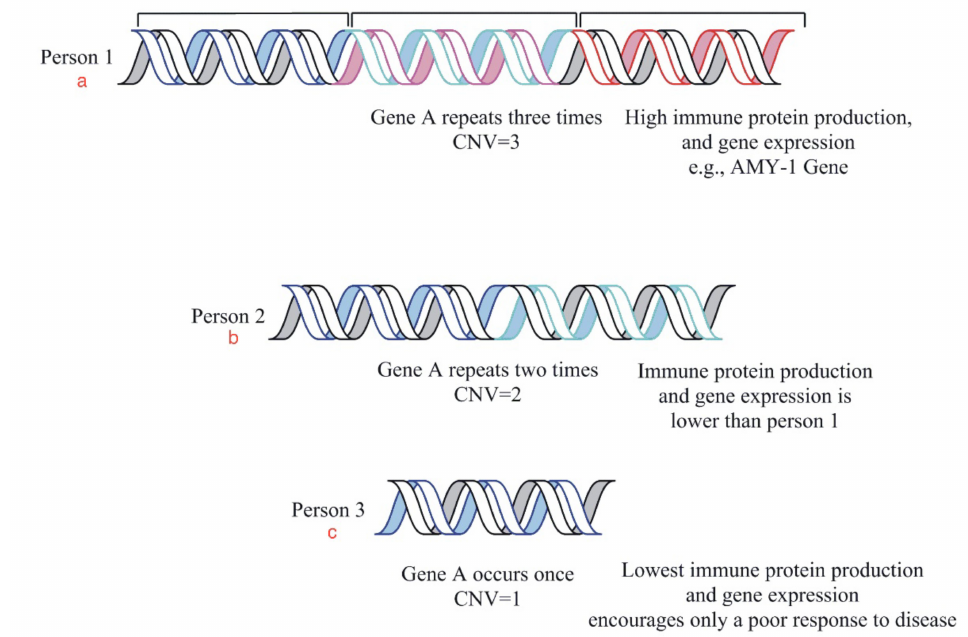
Figure 4. This is a diagrammatic representation of the relationship between gene dosage and gene expression in three individuals. The diagram is an example of the copy number variation phenomenon showing us the variable copy numbers of a gene in different people. The protein production is observed as ( a ) high in person 1, ( b ) moderate in 2 as compared to ( c ) low in person 3 due to the variable number of gene